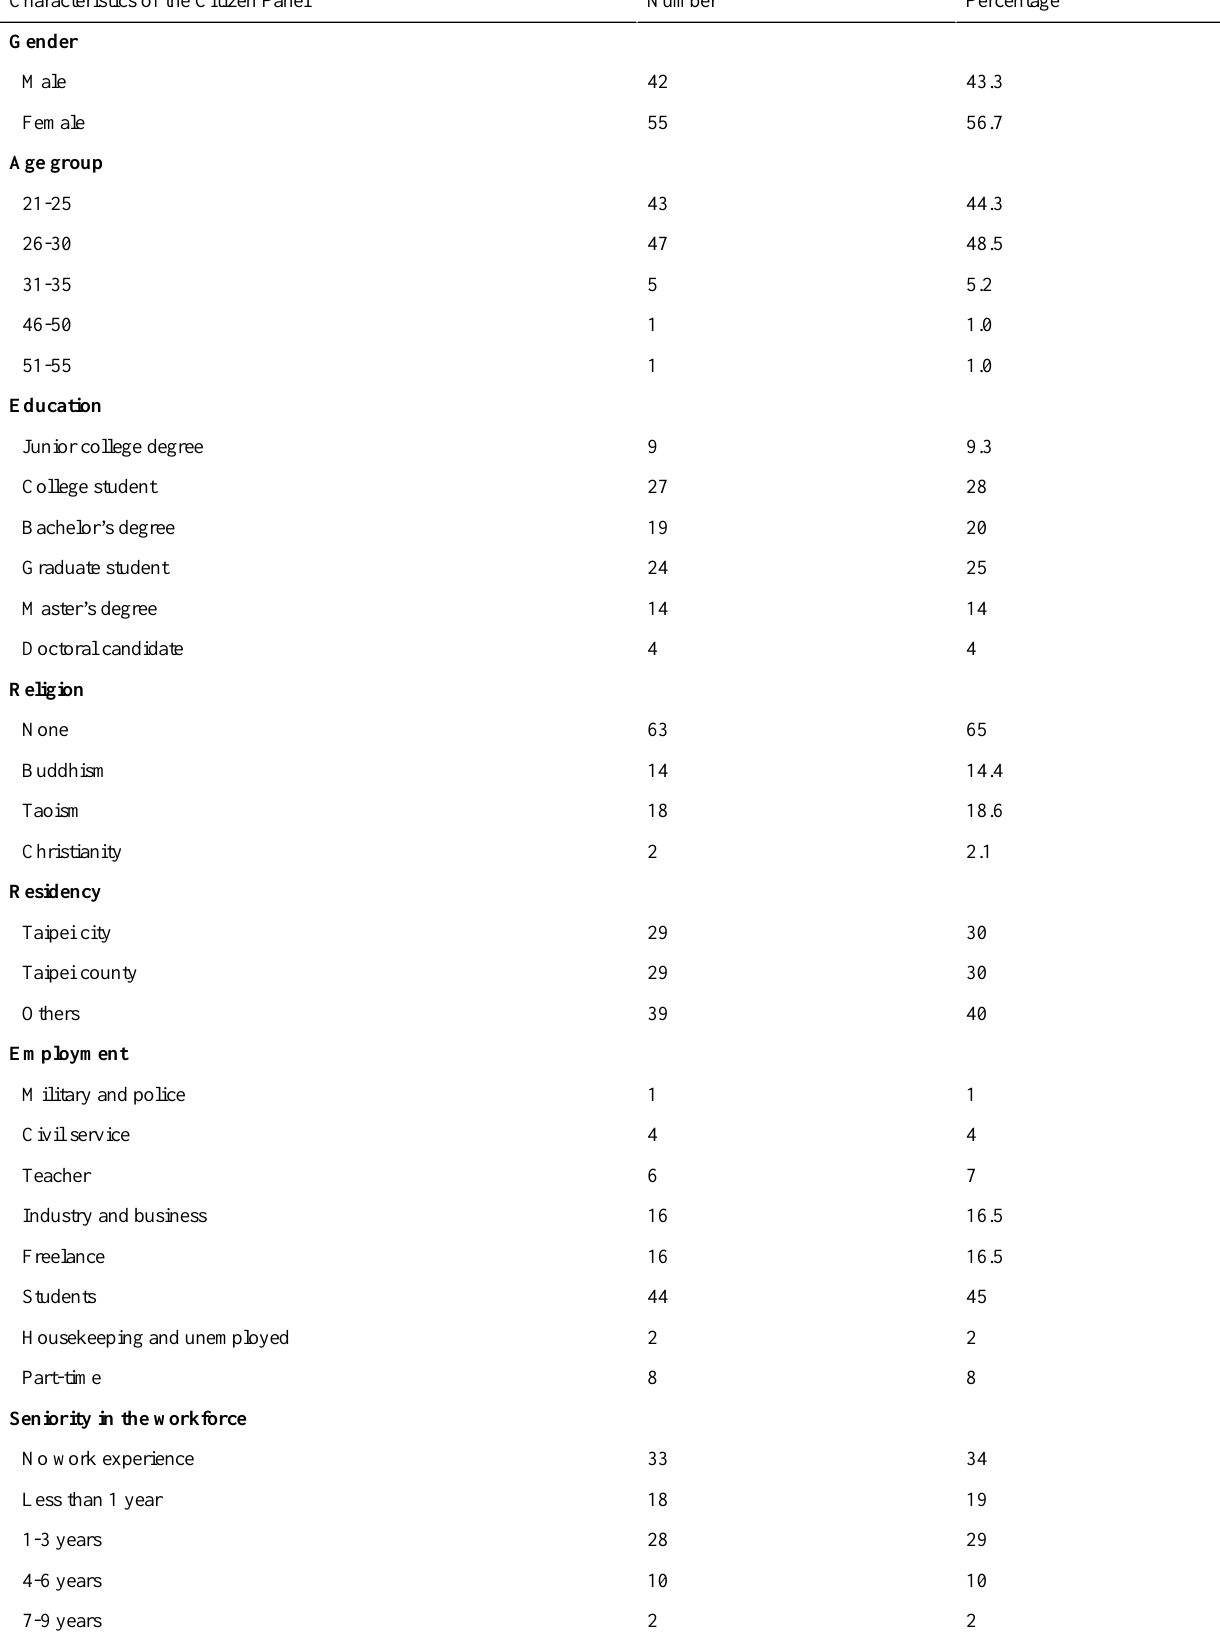
Table 1. Descriptive statistics of the citizen